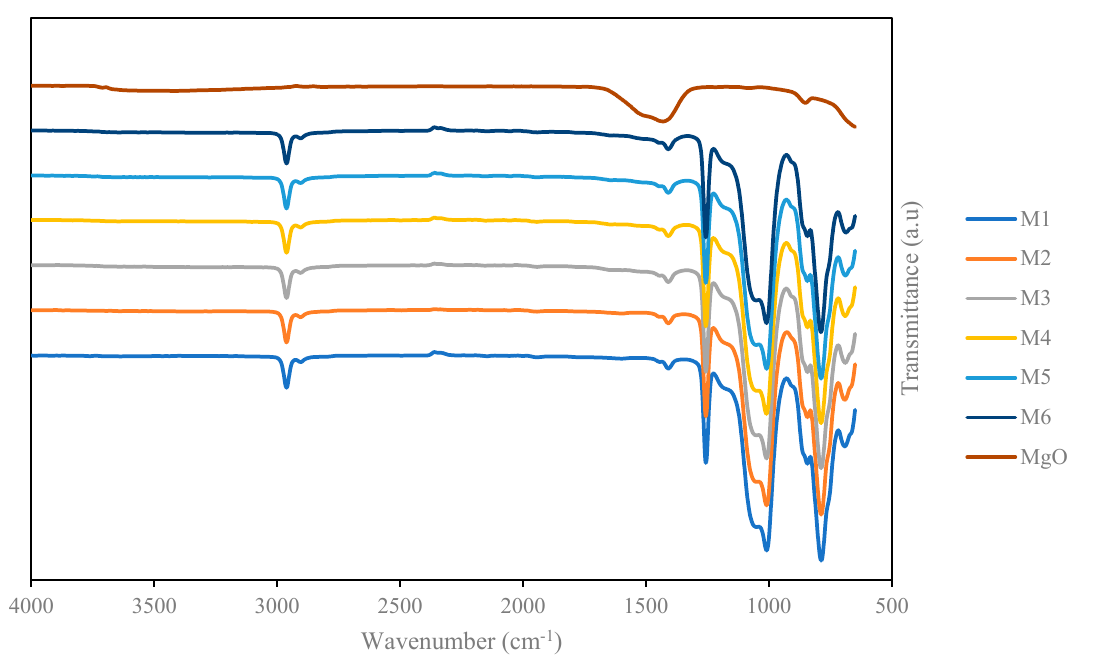
Figure 4. FTIR spectra analysis of PDMS and PDMS/MgO membrane.